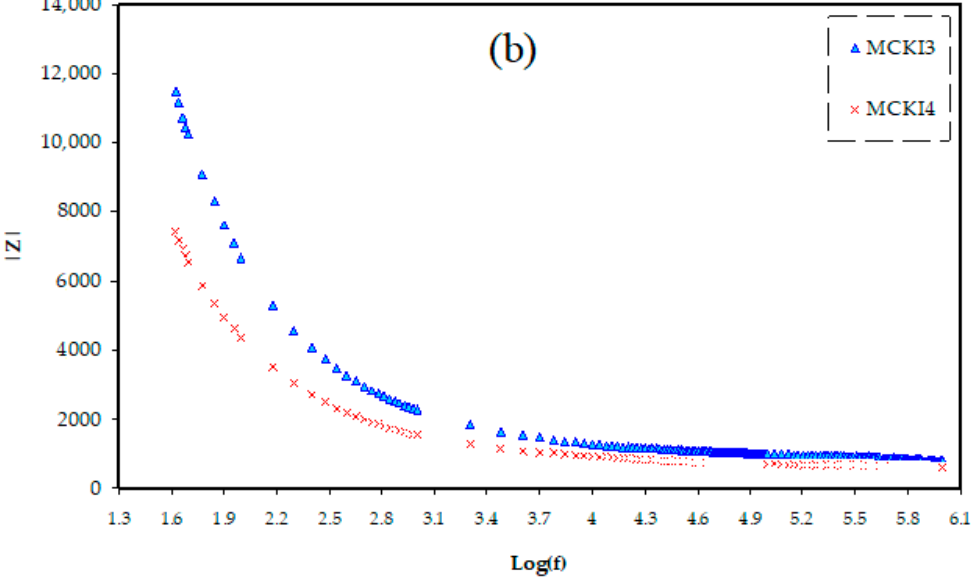
Figure 3. Bode plots for ( a ) MCKI1 and MCKI2 and ( b ) MCKI3 and MCKI4 electrolyte samples.